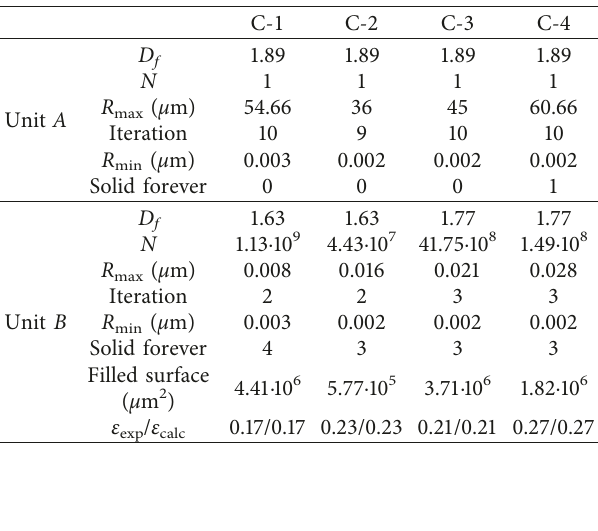
Table 3: IFU input data to models C-1, C-2, C-3, and C-4. The fractal dimension ( D f ), the maximum ( R max ) and minimum rays ( R min ), the number of iterations, the number of solid forever squares for each base unit (the Sierpinski carpet), the number of B base units ( n B ), the filled surface (FS) used to build the IFU, and comparison between experimental ( ε exp ) and predicted pore vol- ume fractions ( ε IFU